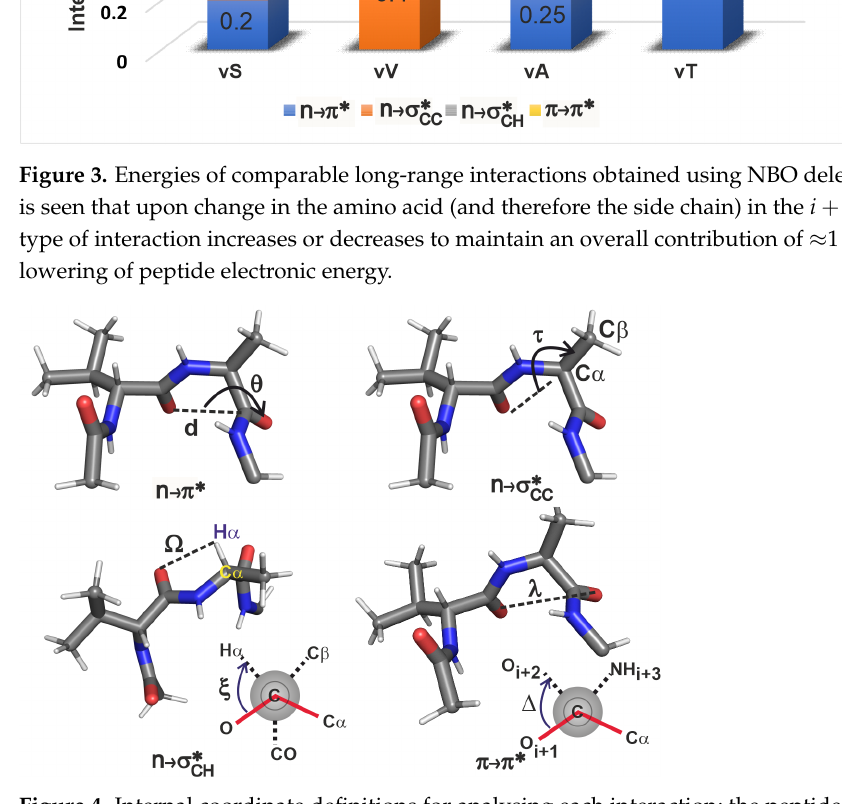
Figure 4. Internal coordinate definitions for analysing each interaction; the peptide shown for each interaction is only illustrative; all the four interactions are analysed for each peptide. The ξ dihedral angle is shown as a Newmann projection, where the C=O of the i + 1 residue is present in front of the plane of the paper, the C i + 2 α is drawn as a grey circle behind the plane of the paper, and the NH of i + 2 residue is not shown. The ∆ dihedral angle is also shown in the Newman projection where the C=O of the i + 1 and i + 2 residues are in the front and back of the plane of the paper respectively, and the C α and NH groups of the i + 2 residue are not